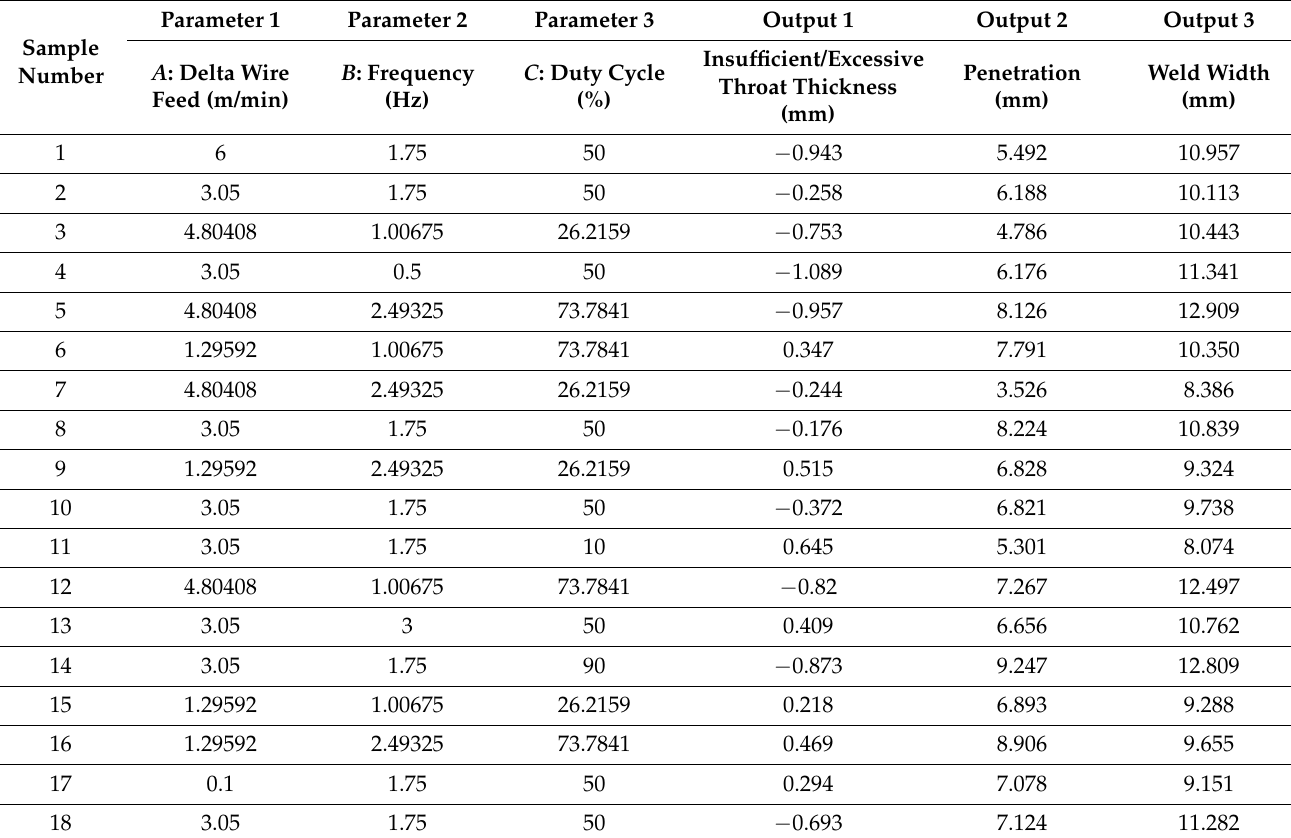
Table 6. Obtained output values.